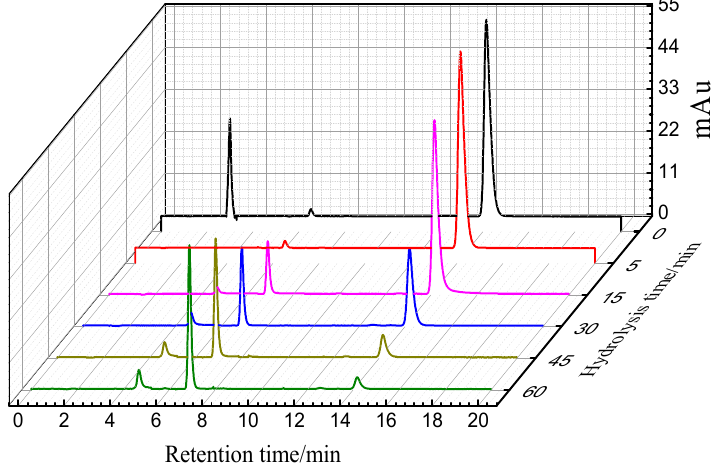
Figure 2. HPLC chromatograms of C.I. Reactive Blue 19 at pH = 11, temperature at 70 °C in siloxane emulsion dyeing system.